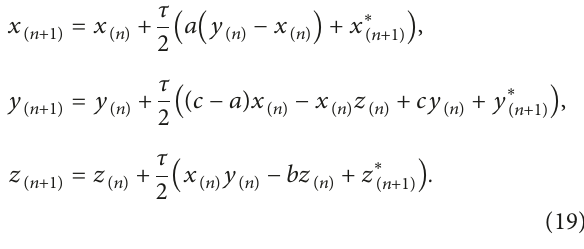
( n ) versus z ( n ) and (b) evolution of state variables